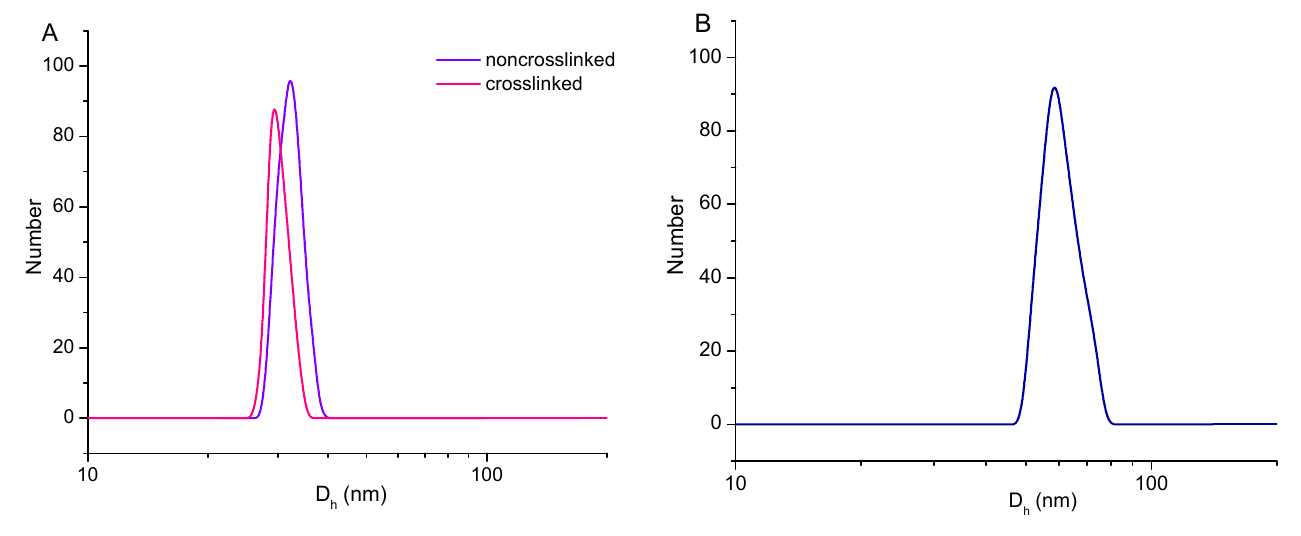
Figure 2. Size distribution plots of: ( A ) non-crosslinked and crosslinked micelles in PBS, and ( B ) crosslinked micelles in THF. Micelles were formed by co-assembly of PEO 113 -b-PCL 35 -b-PEO 113 and PAA 13 -b-PCL 35 -b-PAA 13 amphiphilic triblock copolymers at molar ratio 3:1. The zeta protentional of crosslinked micelles ( − 9 mV) is higher as compared to the non-crosslinked ones, which can be explained with the diminishing of free carboxyl groups in the micellar structure. The data are summarized in Table 1. Table 1. Dynamic and electrophoretic light scattering data of blank and CAPE-loaded mixed copoly- mer micelles prepared from PEO 113 - b -PCL 35 - b -PEO 113 and PAA 13 - b -PCL 35 - b -PAA 13 amphiphilic triblock copolymers by co-assembly in PBS (pH